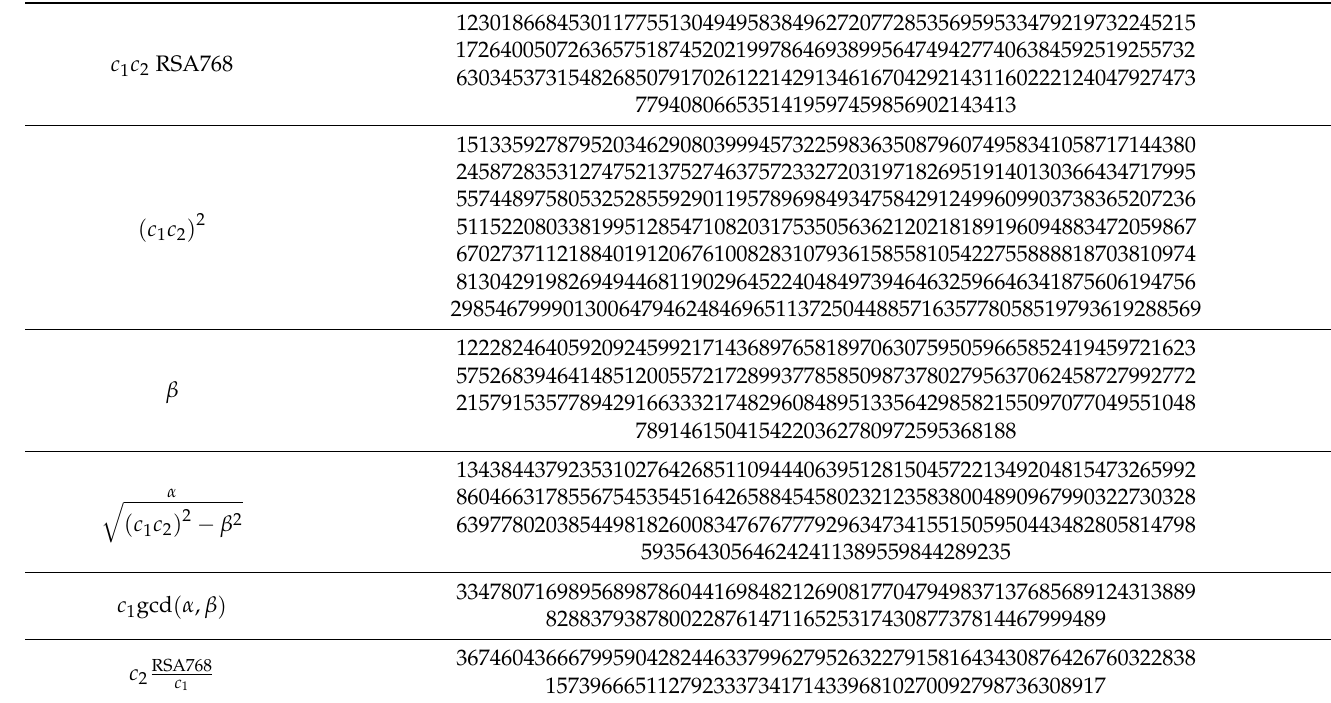
Table 1. Application of the proposed semi-prime factorization method for RSA-768